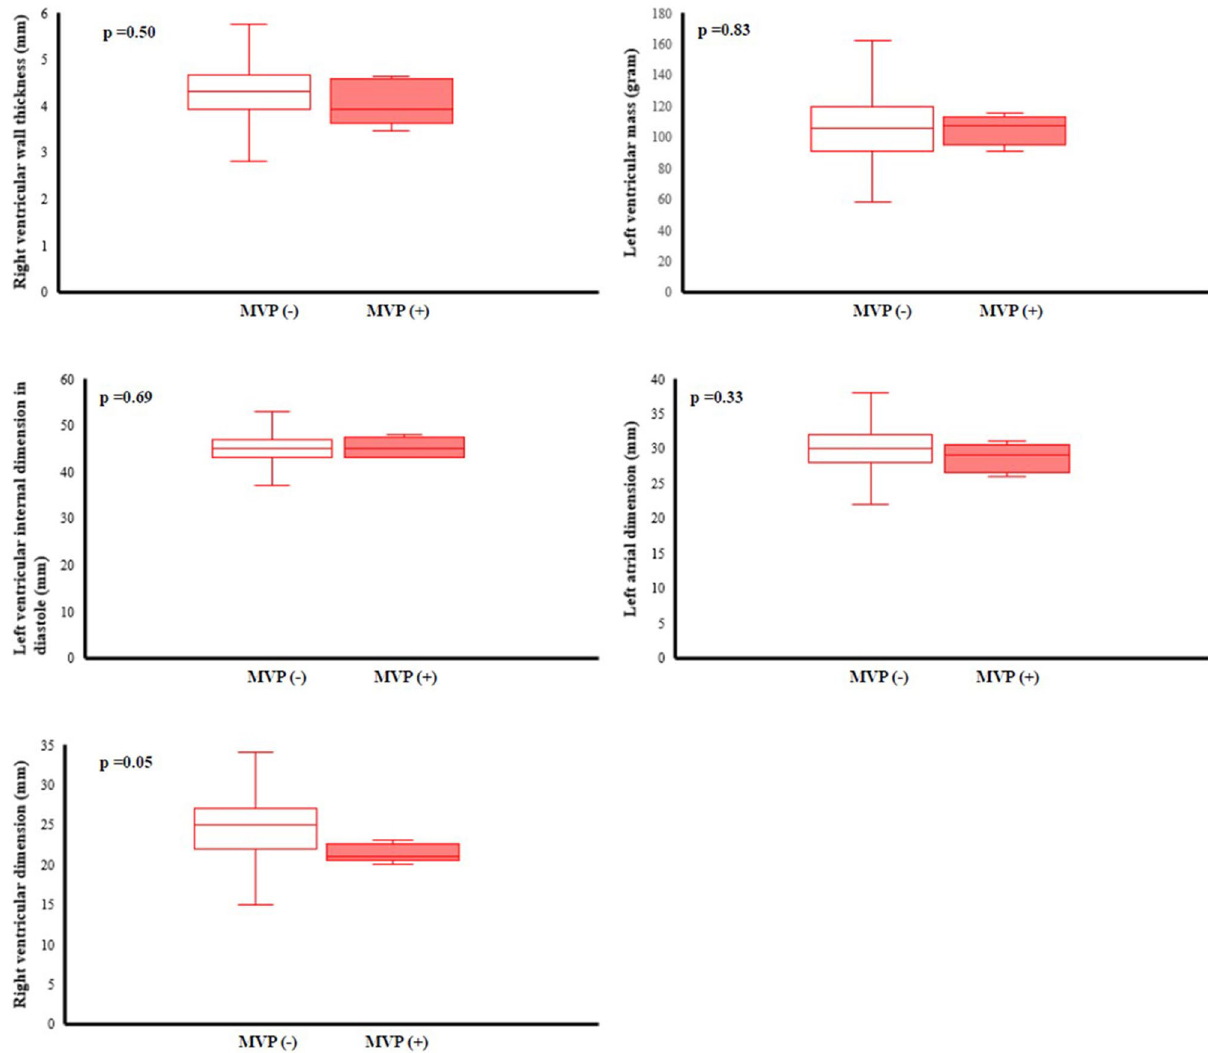
females were compared using analysis of covariance with adjustment for body surface